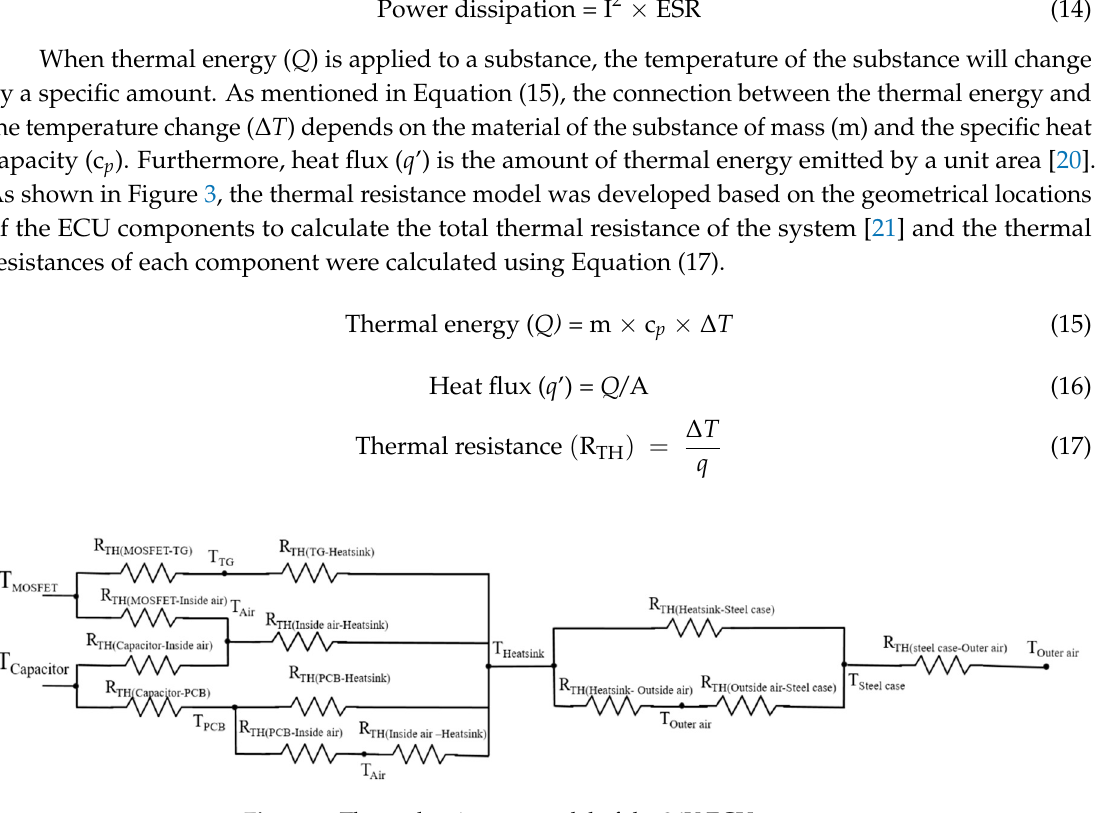
Figure 3. Thermal resistance model of the 36V ECU system.